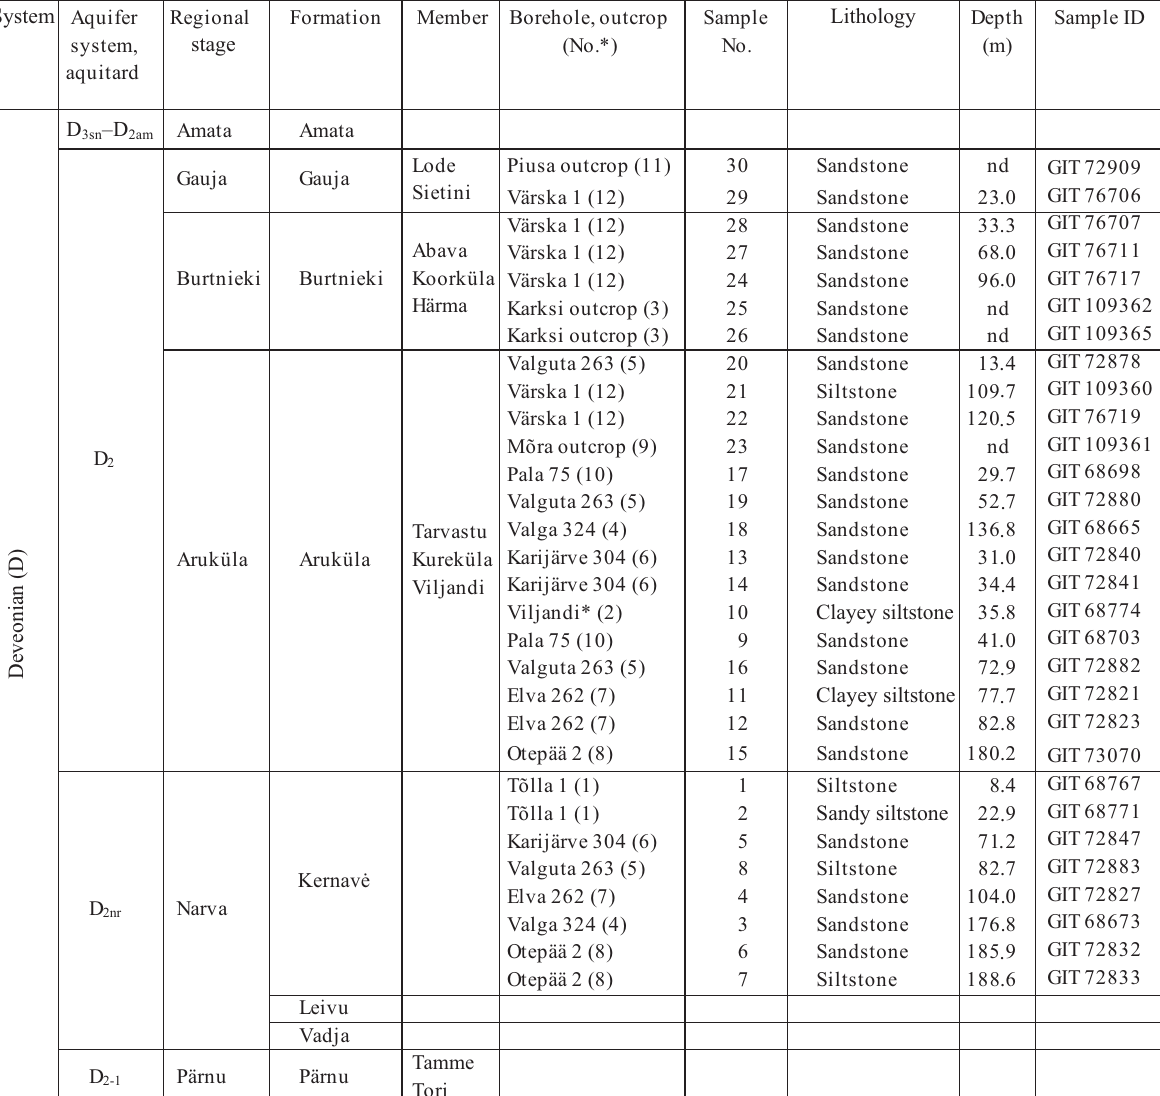
Table 1. Stratigraphical (Mark­Kurik & Põldvere 2012) and hydrostratigraphical (Perens & Vallner 1997) background of the rock samples. D 3sn –D 2am , Snetnaja Gora–Amata aquitard; D 2, Middle Devonian aquifer system; D 2nr , Narva aquitard; D 2­1, Middle–Lower Devonian aquifer system; No.*, borehole or outcrop number in accordance with Fig. 1C; Sample ID, sample number in the database SARV; nd, no